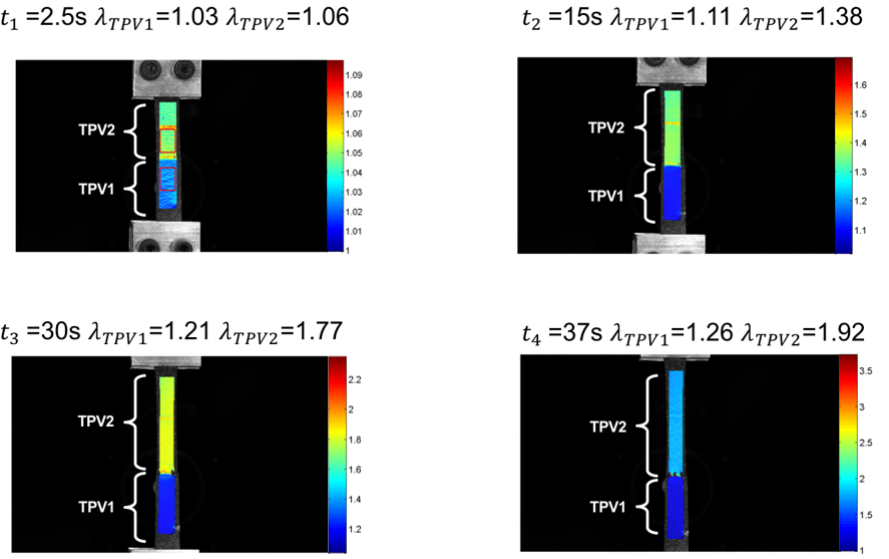
Figure 12. Stretch evolution for each TPV overmoulded at 260 ◦ C, in the case of monotonic tensile test until rupture.